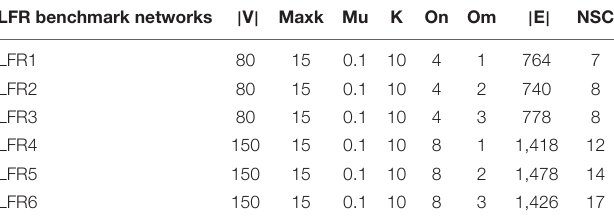
TABLE 2 | LFR benchmark